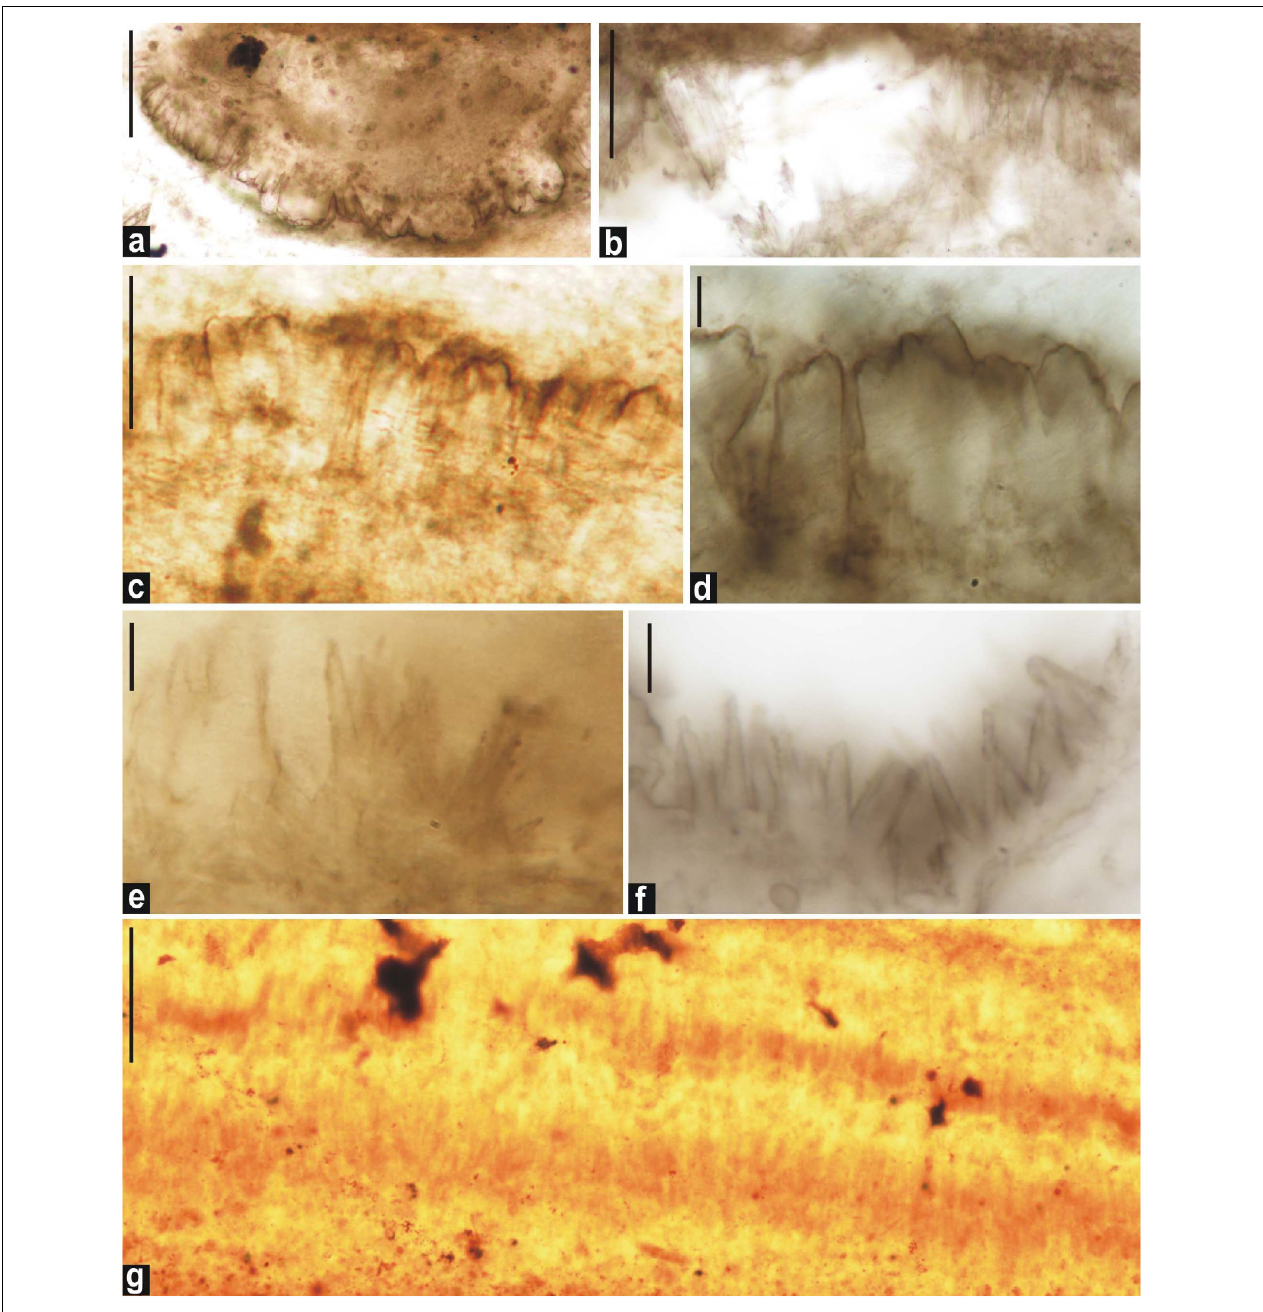
FIGURE 9 | Fan-fabrics from the thin sections of chert from the Salkhan Limestone. (a) : Distribution of coccoid cyanobacterial microfossils over fan-shaped blades of aragonite crystals pseudomorphs; (b–f) : gradual enlargements of the blade shaped crystal pseudomoprhs of aragonite; (g) : akinetes entrapped in crystal pseudomorphs. Scale bars = a,b,g = 100 µ m and c–f = 10 µ